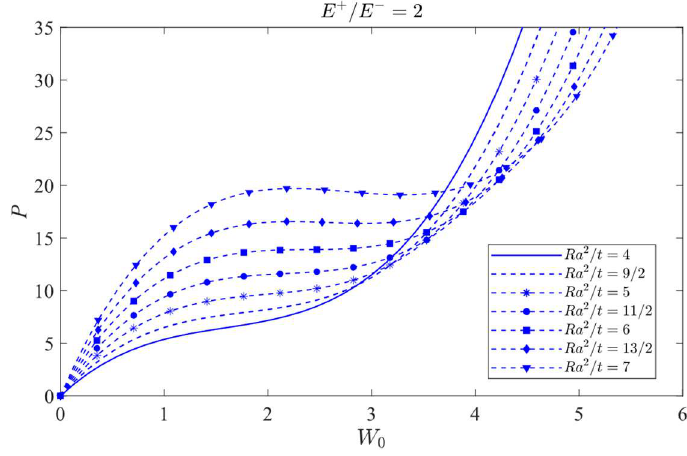
Figure 16. Load vs. central deflection when λ = 1/2 and E + / E − = 2.